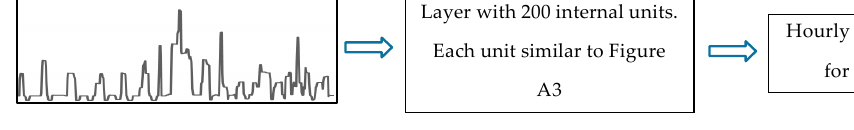
Figure A4. LSTM Figure A4. LSTM model.